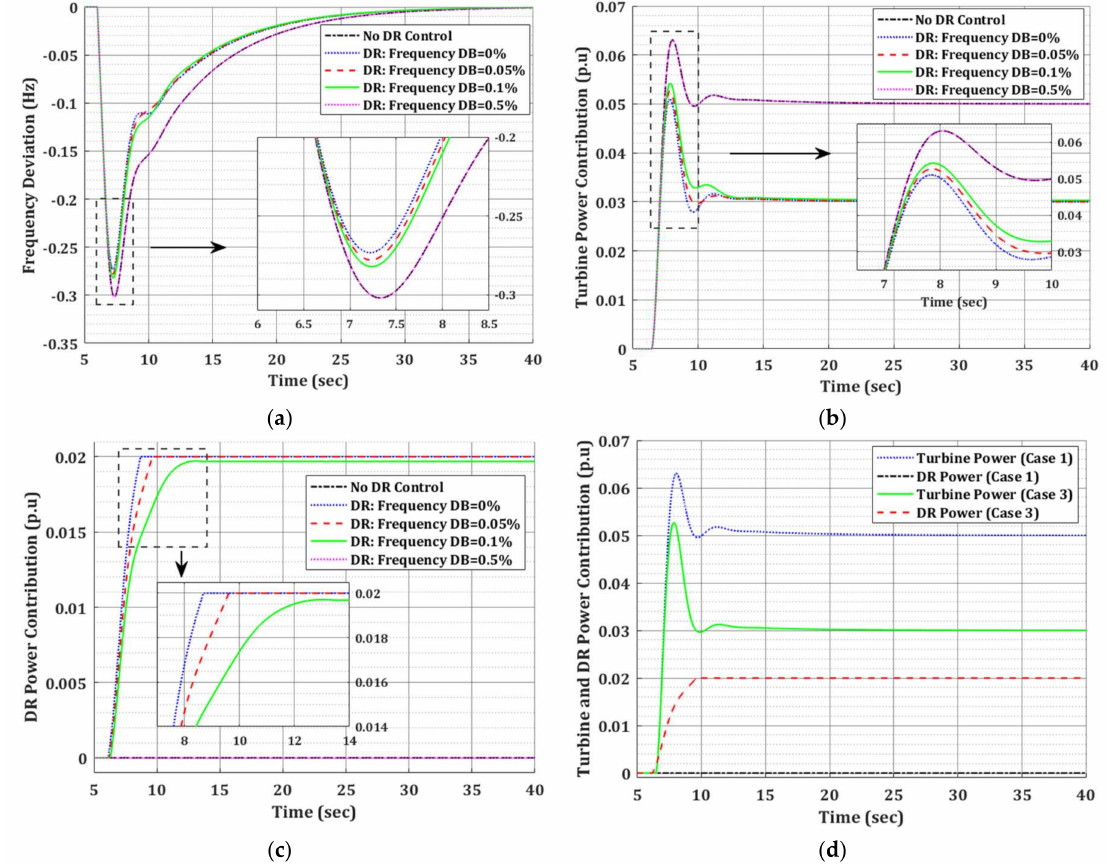
Figure 6. Effect of frequency deadband ( f DR , DB ) on various system parameters under load disturbance: ( a ) system frequency response; ( b ) change in turbine power (p.u); ( c ) change in DR power (p.u); and ( d ) change in turbine and DR power (p.u) for selected